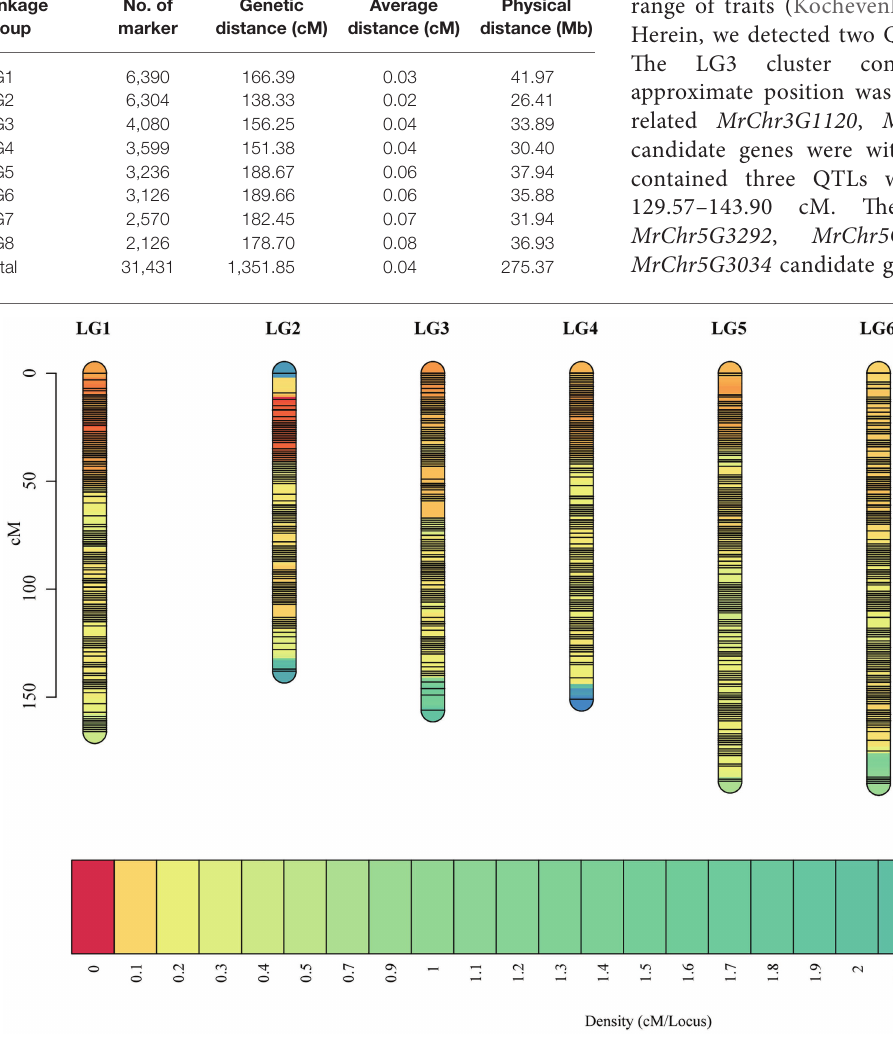
TABLE 1 | Genetic and physical map details. Linkage